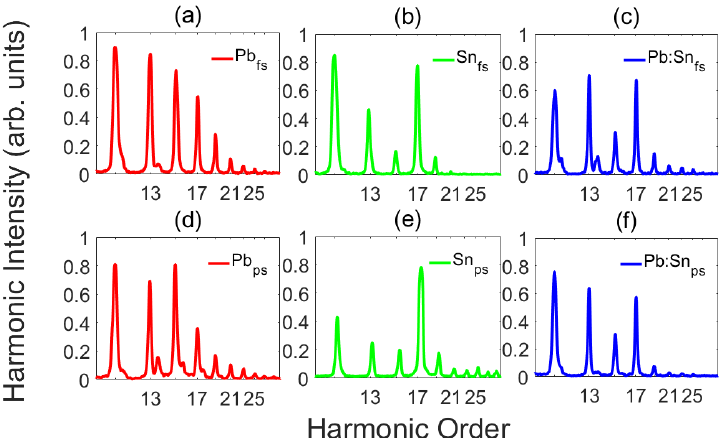
Figure 2. Spectral distributions of the harmonics generated in Pb (red lines), Sn (green lines) and Pb-Sn alloy (blue lines) plasmas produced by 800 nm, 35 fs, 100 Hz (upper panels) and with 800 nm, 200 ps, 100 Hz (lower panels) heating pulses. All vertical axes are in linear scale.